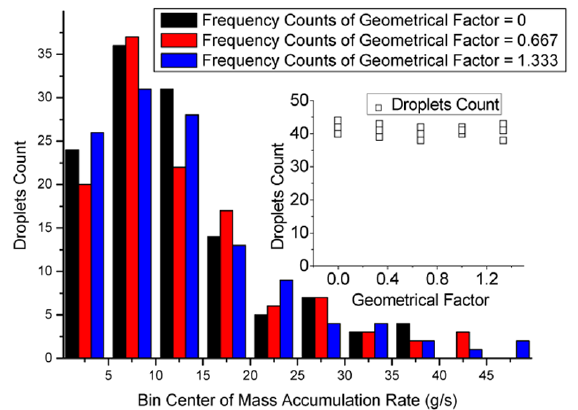
Fig. 8. Mass accumulation, its first order derivative and the 50 points smoothed curve as a function of time for geometrical factor 0 α= configuration